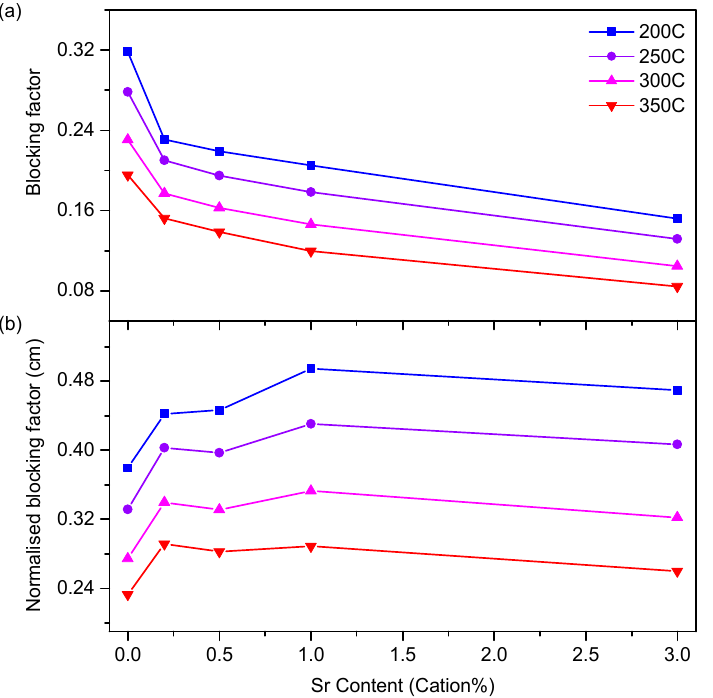
Figure 12. Plots of ( a ) blocking factor and ( b ) normalised blocking factor against strontium content for measurement temperatures from 200 °C to 350 °C.